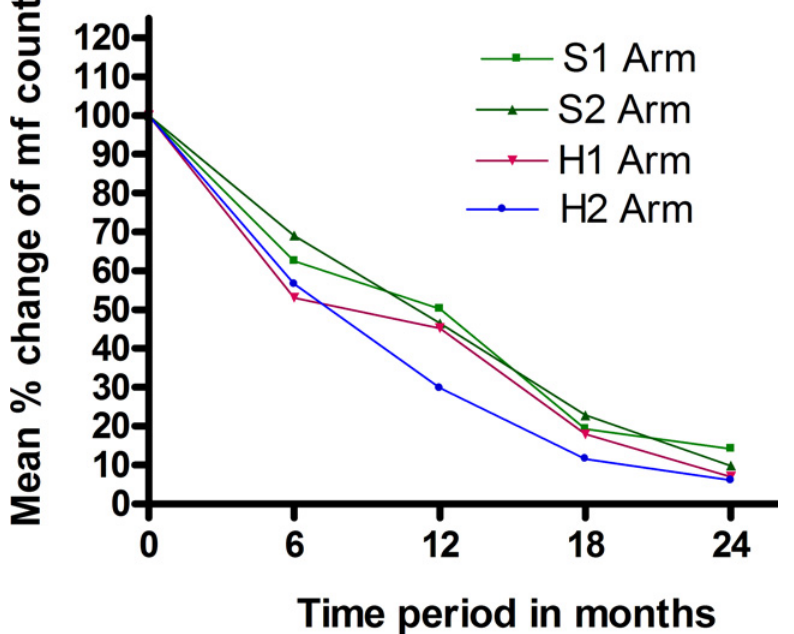
Fig 1. Mean percentage reduction in individual microfilarial count compared to baseline. Percentage changes from baseline values for individuals were calculated at each follow-up point and then means for each treatment group derived.